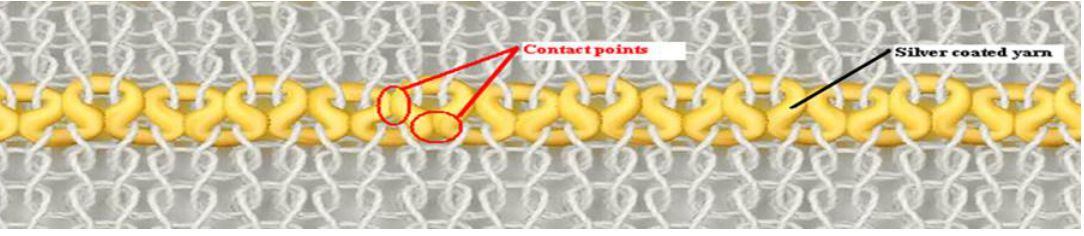
Figure 3. Schematic diagram of textile sensor showing the conductive loops in a single knitted course and the contact points between successive conducting